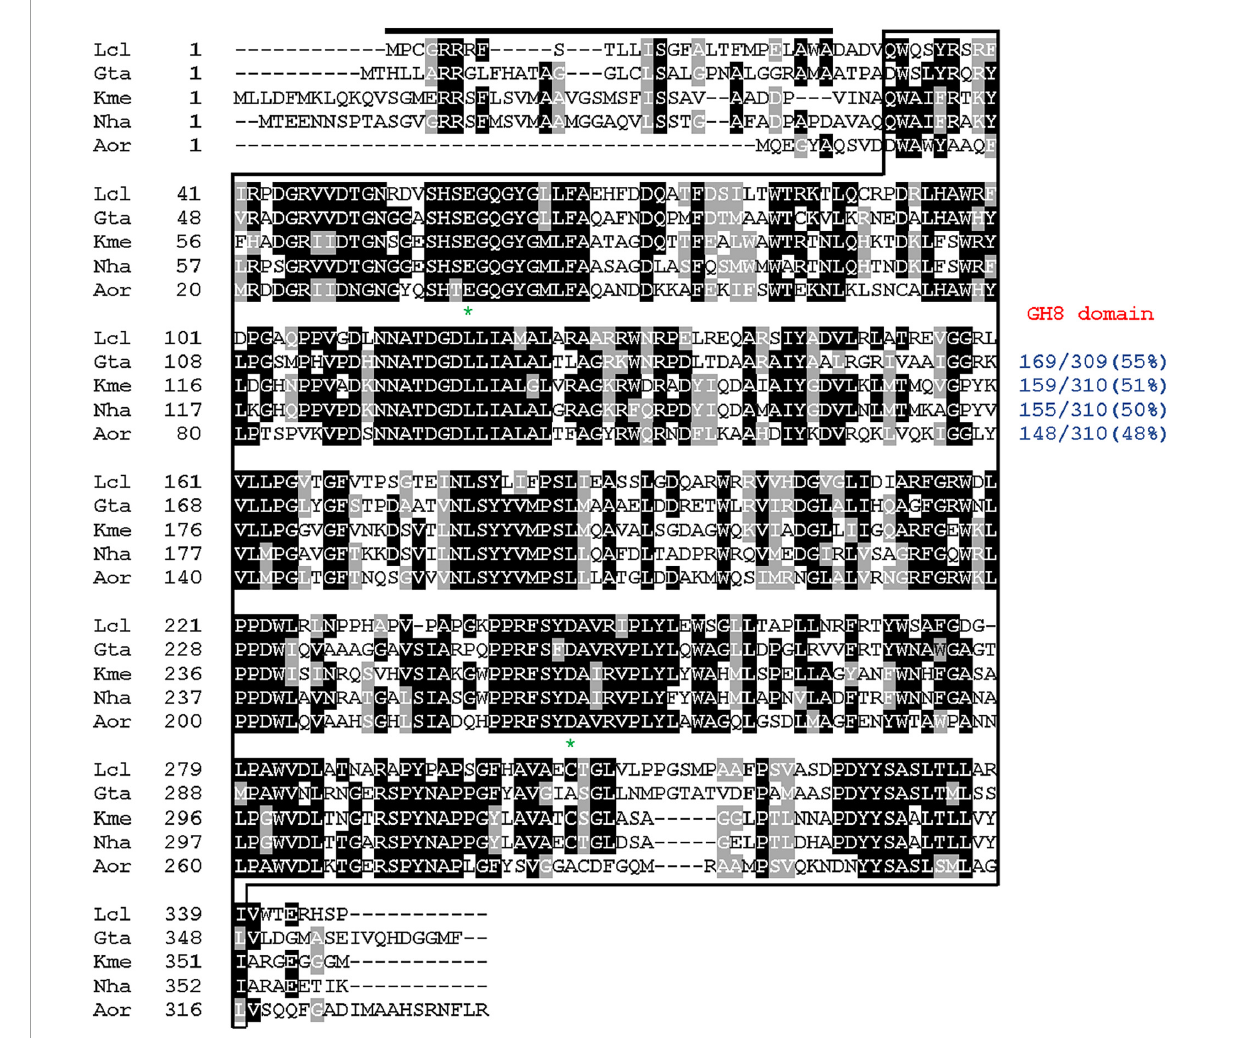
FIGURE1 Primary sequence alignment of Lichenicola cladoniae PAMC 26568 GH8 endo- β -1,4-glucanase and its structural homologs. Sequences (GenBank accession numbers): Lcl, L. cladoniae PAMC 26568 endo- β -1,4-glucanase (ON016586); Gta, Gluconacetobacter takamatsuzukensis glycosyl hydrolase family 8 (WP_182950054); Kme, Komagataeibacter medellinensis NBRC 3288 endo- β -1,4-glucanase (BAK84916); Aor, Acetobacter orientalis endo- β -1,4-glucanase (GAN65284); Nha, Novacetimonas hansenii endoglucanase (QOF96800). The identical and similar amino acids are shown by black and gray boxes, respectively. The predicted signal peptide is indicated by a black bar and GH8 domain is outlined by solid line. Highly conserved amino acid residues that play an essential role in biocatalysis are indicated by